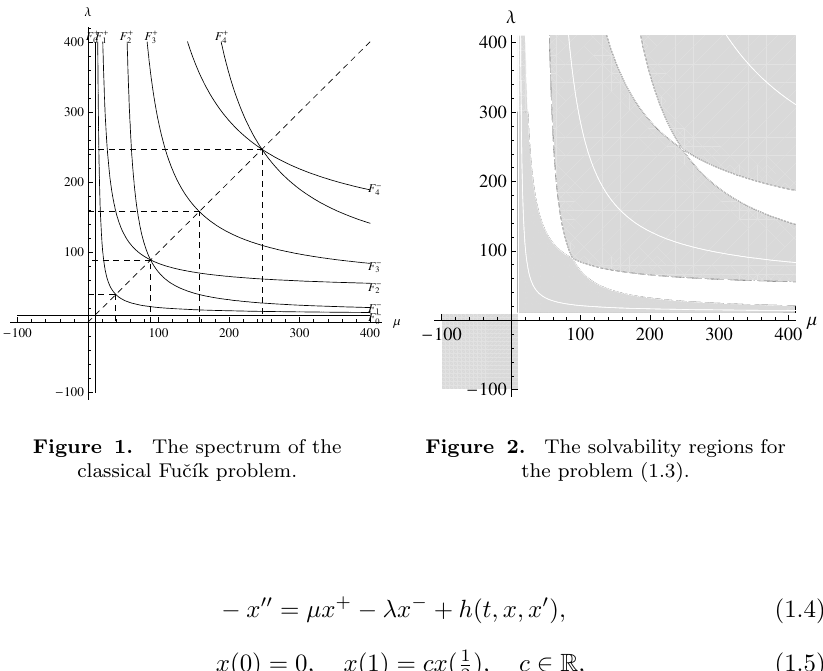
Figure 1. The spectrum of the classical Fuˇc´ık problem.